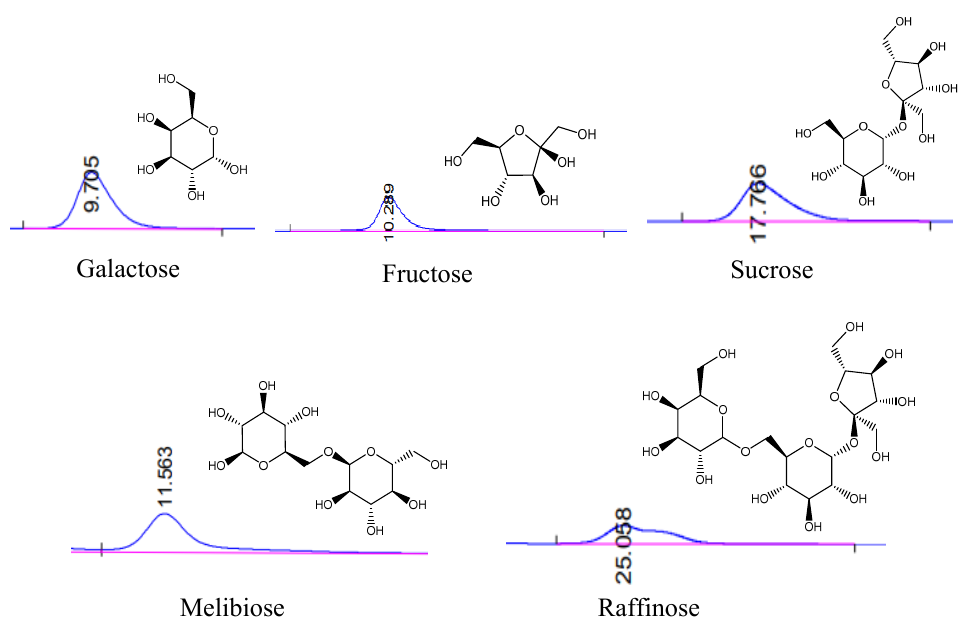
Figure 7. Analysis of the contents of oligosaccharides by HPLC.